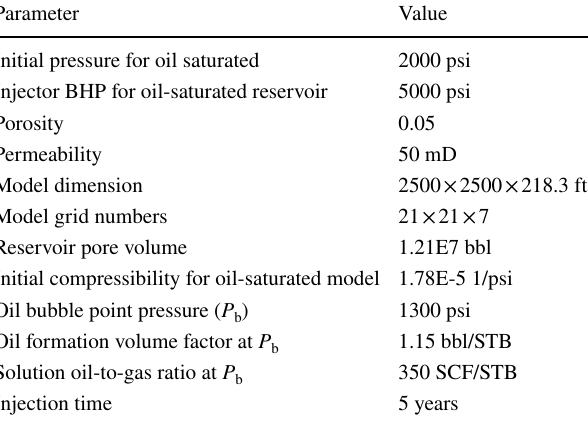
Table 1 Essential input parameters of the simulation synthetic case Parameter